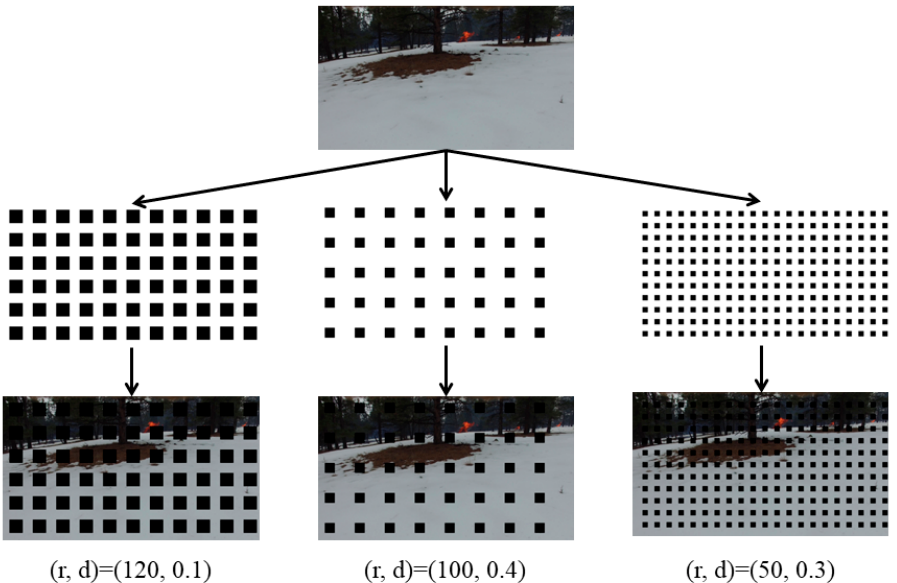
Figure 4. Gridmask with different scales for data augmentation.